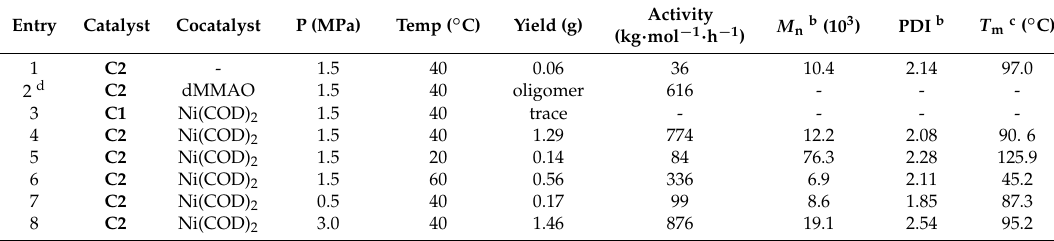
Table 1. Ethylene polymerizations with complexes C1 and C2 a